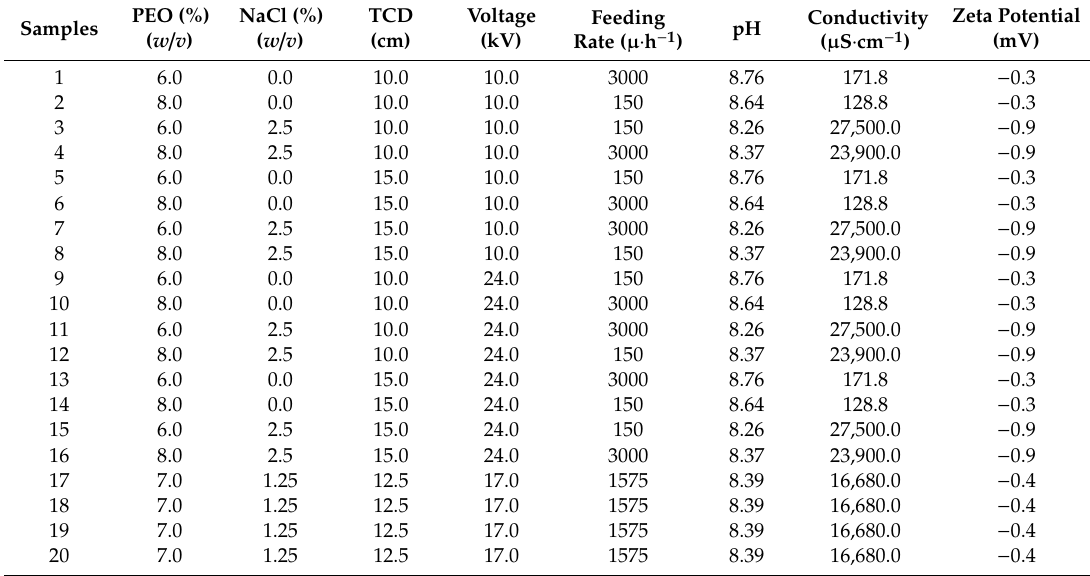
Table 1. Parameters (feeding rate, PEO concentration, NaCl concentration, tip-to-collector distance (TCD), and applied voltage) used to evaluate the production of electrospinning nanostructures in the fractional factorial